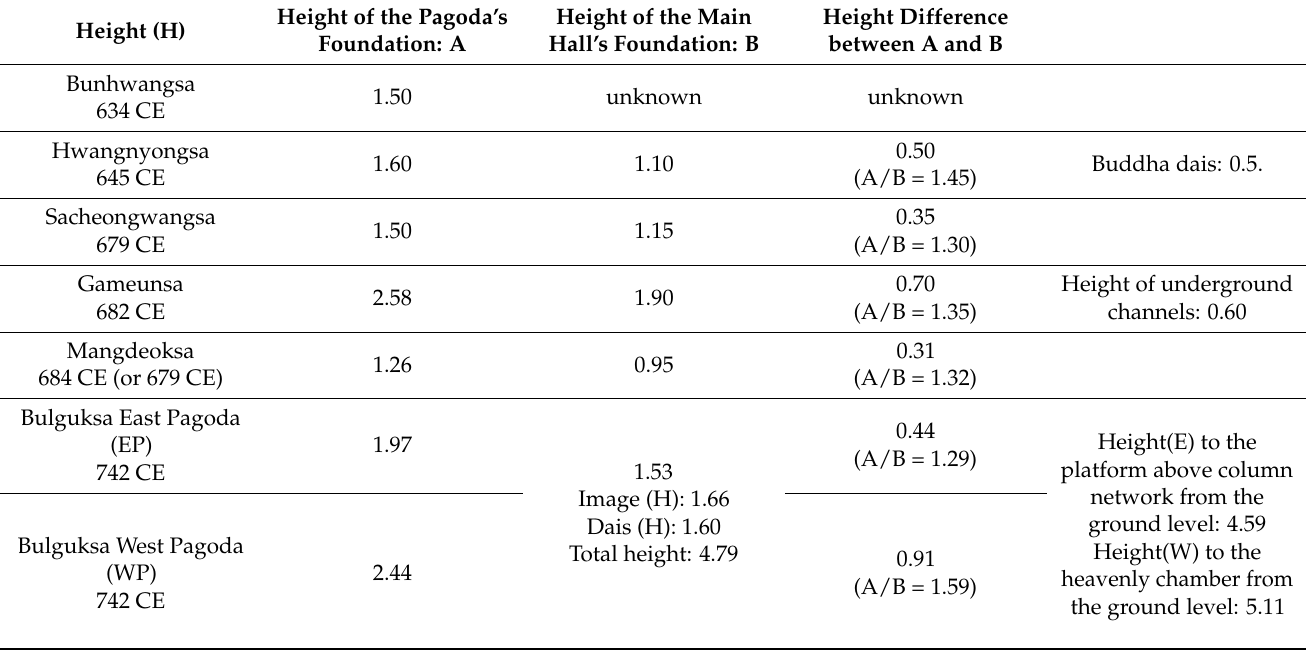
Table 1. Comparison in Height between the Pagoda’s Foundation and the Main Hall’s Foundation (Measurement unit: